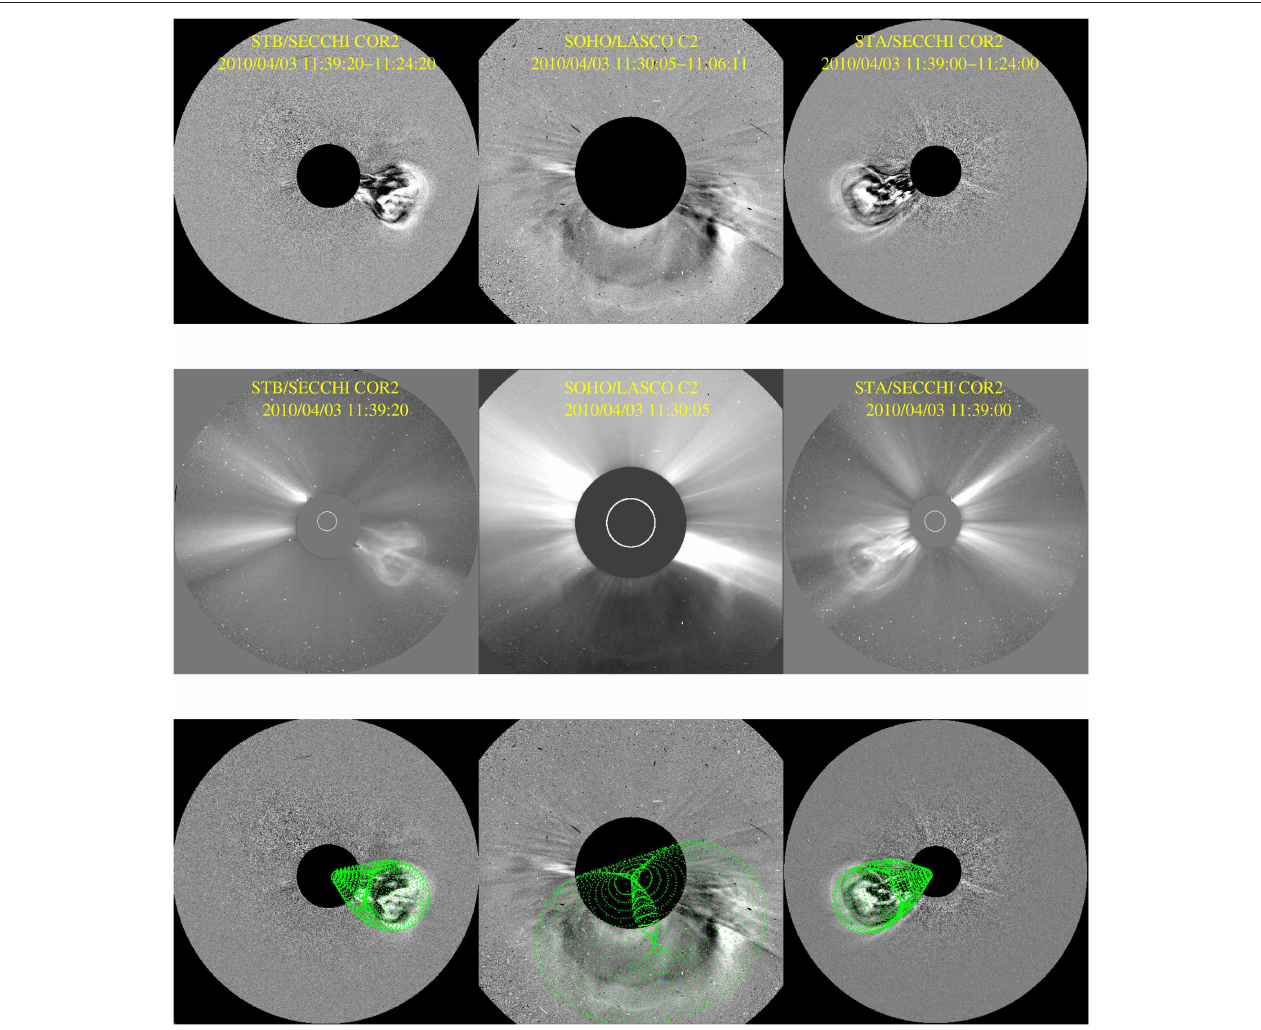
FIGURE 2 | The observation of 3 April 2010 CME from three different viewing angles. The triplet of concurrent images are taken from STEREO /COR2-B (left) , SOHO/LASCO-C2 (middle) , and STEREO /COR2-A (right) around 11:39 UT on 3 April 2010. The top, middle and bottom panels show the running difference images, direct images, running difference images having GCS model wire-frame overlaid with green, respectively.